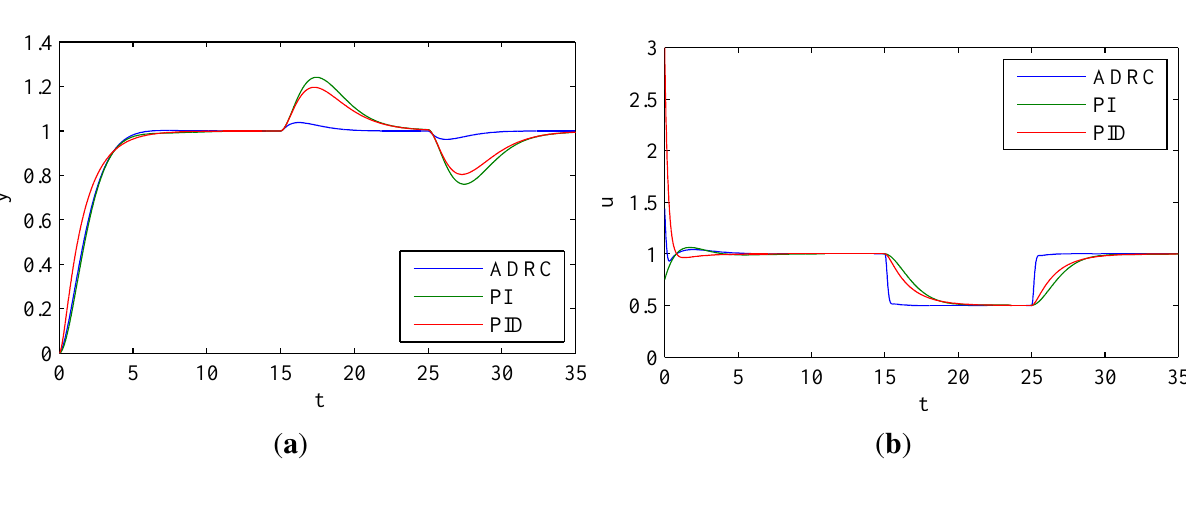
Figure 17. Experiment 3.2.7: comparison of disturbance rejection behavior (second-order ADRC vs . PI vs . PID controller). Process and ADRC parameters are as throughout Section 3.2. Input disturbance, d = 0 . 5, effective from t = 15 until t = 25. ( a ) Step response and reaction on disturbance; ( b ) Controller output u for ( a